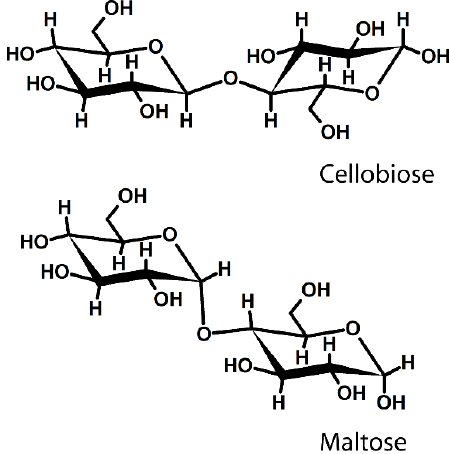
Figure 1. Glycosidic linkage between two different saccharide units. Schematic representation of cellobiose ( top ) and maltose ( bottom ). In the first case, the anomeric carbon (C2) is in the beta configuration (equatorial), while in the second case, it is in the alpha configuration